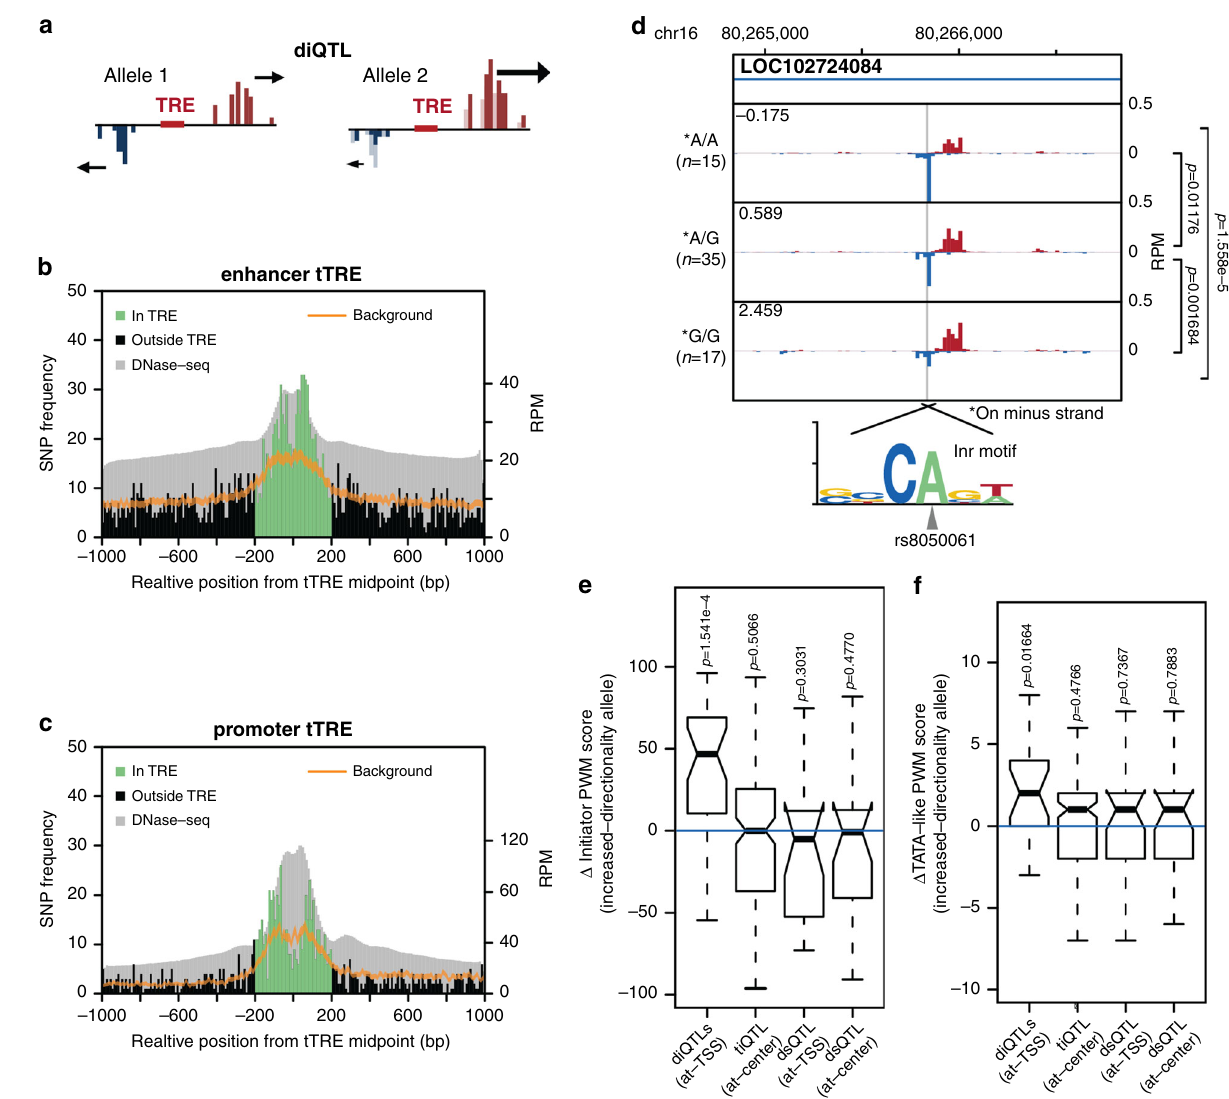
Fig. 4 Directional initiation QTLs are enriched at TSSs and affect core promoter elements. a Directional initiation QTL (diQTL) schematic. b diQTLs are enriched at enhancer TSSs. A histogram of QTL frequency around enhancer midpoints with the expected background distribution with 99% con fi dence interval (sampled from all SNPs in the same region) shown in orange and aggregate DNase-seq track shown in gray. c diQTLs are enriched at promoter TSSs. As in b , at promoters except oriented so that the strand with dominantly transcribed TSS is downstream of the TRE center. d Average PRO-cap signal separated by genotype at diQTL rs8050061. The alternate allele disrupts a canonical human Inr motif. Mean directionality index of each genotype indicated in the upper left corner. Comparison of directionality index between groups using two-sided Wilcoxon text. Exact p -values are p = 0.012 between A/A and A/G, p = 0.0017 between A/G and G/G, and p = 1.6×10 − 5 between A/A and A/G. e Difference in Inr PWM score with effect size not equal to zero between increased and decreased directionality allele for diQTLs within 10bp from the TSSs (at-TSS), with tiQTLs within 10bp from the tTRE center (at-center) and dsQTLs within 10bp from either TSS or center included for comparison. Center line of the boxplot indicates the median, box limits are the 25th and 75th quantiles, whiskers are the 1.5× interquartile range, and the notch re fl ects the 95% con fi dence interval for the median. Exact p -values are 1.5×10 − 4 , p = 0.51, p = 0.30, and p = 0.48 respectively. ( n = 19, 192, 28, and 27 QTLs respectively). f As in e , for TATA-box. Here (at-TSS) indicates 40 to 20bp upstream of TSS, where TATA-box is usually found. Exact p -values are 0.017, p = 0.48, p = 0.74, and p = 0.79 respectively. ( n = 34, 152, 21, and 22 QTLs